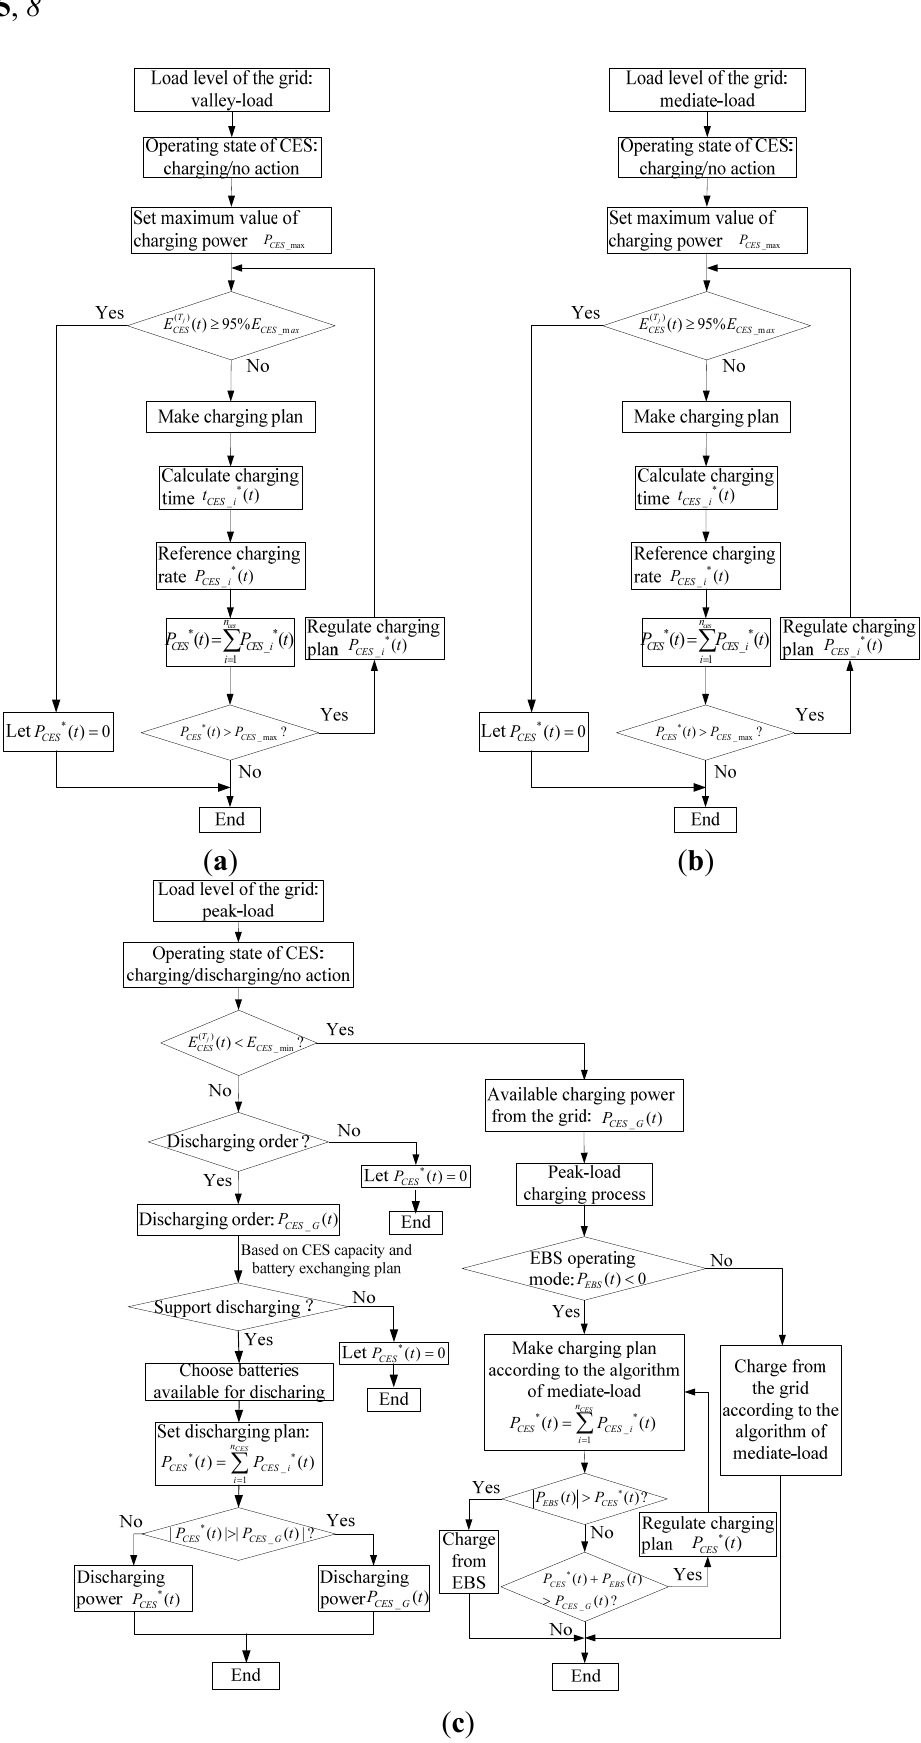
Figure 9. Charging discharging algorithm of CES at different load status. ( a ) During valley load periods ( b ) During mediate load periods; ( c ) During peak load